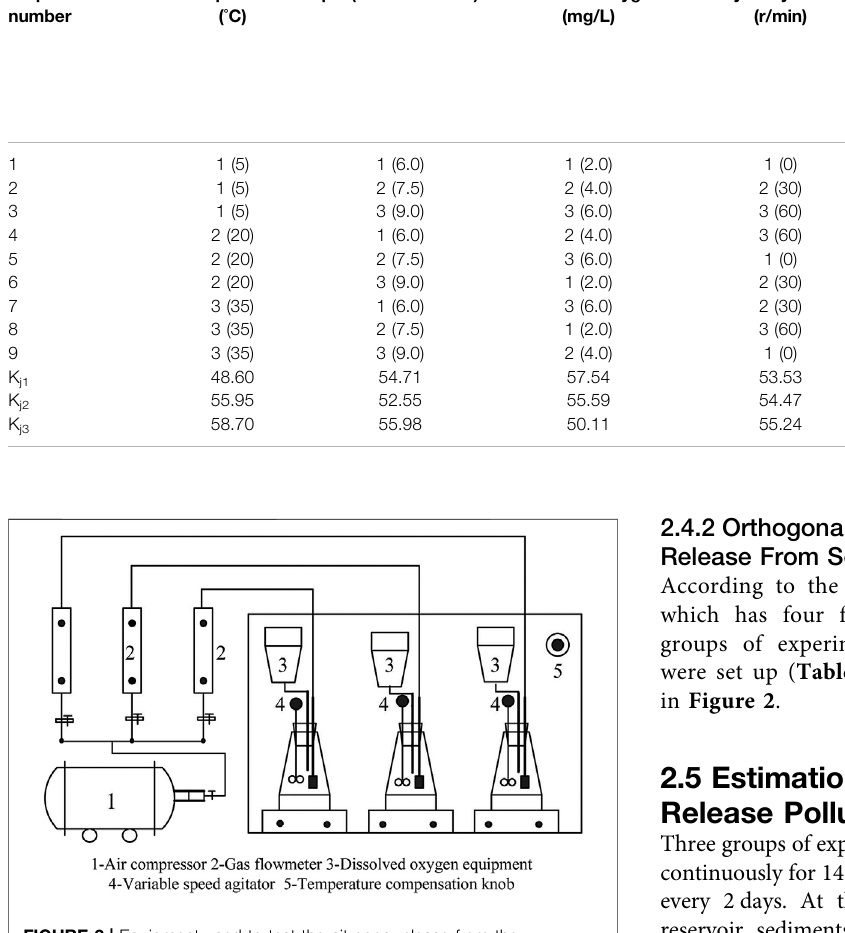
FIGURE 2 | Equipment used to test the nitrogen release from the